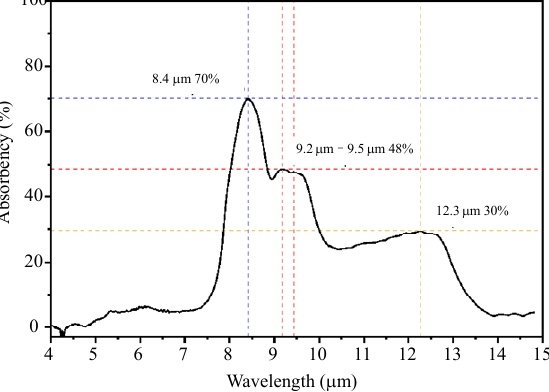
Fig. 3 Infrared absorption spectra of SiO 2 -Si 3 N 4 -Si 3 N 4 composite film